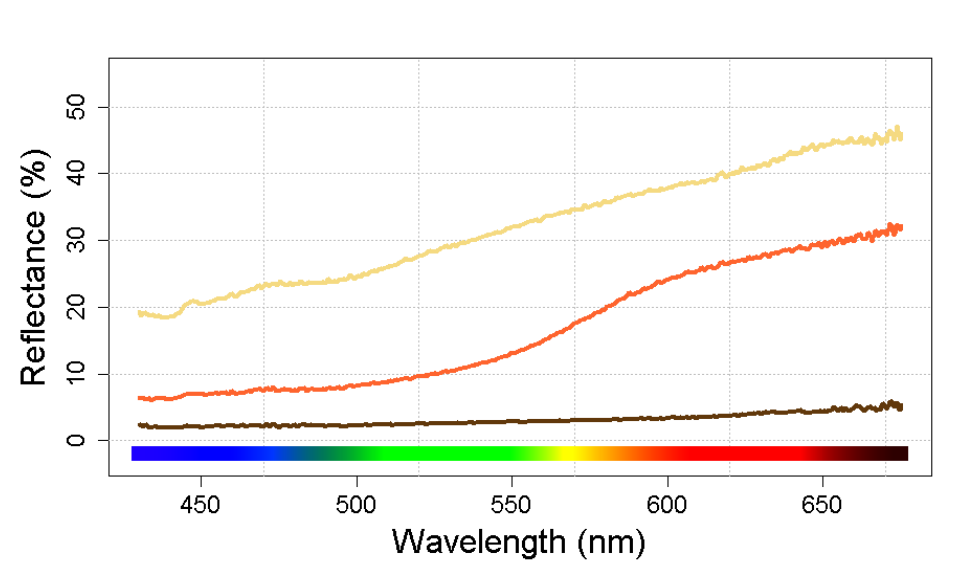
FIGURE 1 | Reflectance of the types of substrates commonly found in igarapés in the Amazon forest: dead leaves (brown), clay (orange) and sand (yellow). The strong dissimilarity between white sand and dead leaves creates a higher contrast at the environment.